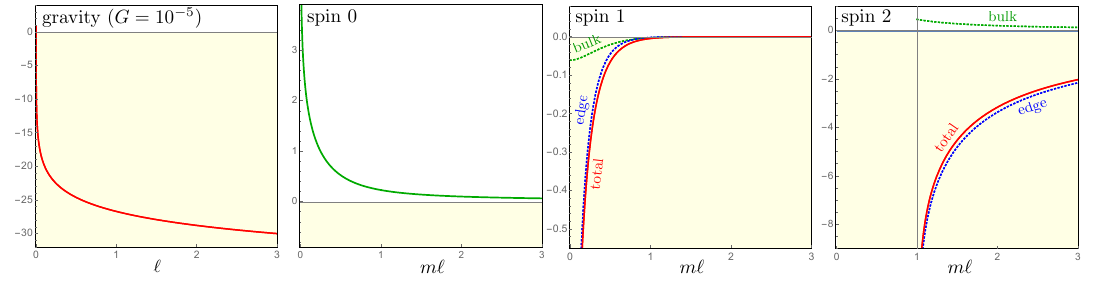
Figure 2 . Contributions to dS 3 one-loop entropy from gravity and massive s = 0 , 1 , 2 .